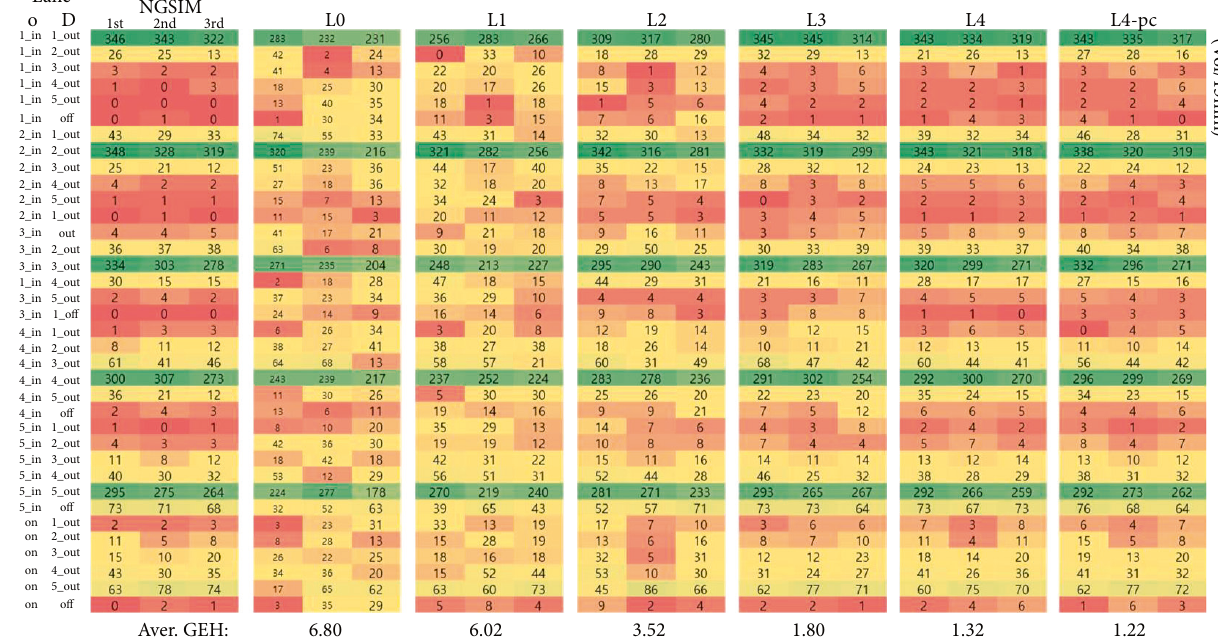
Figure 5: Comparison of GEH heat map of O–D per lane in 15 min for each calibration